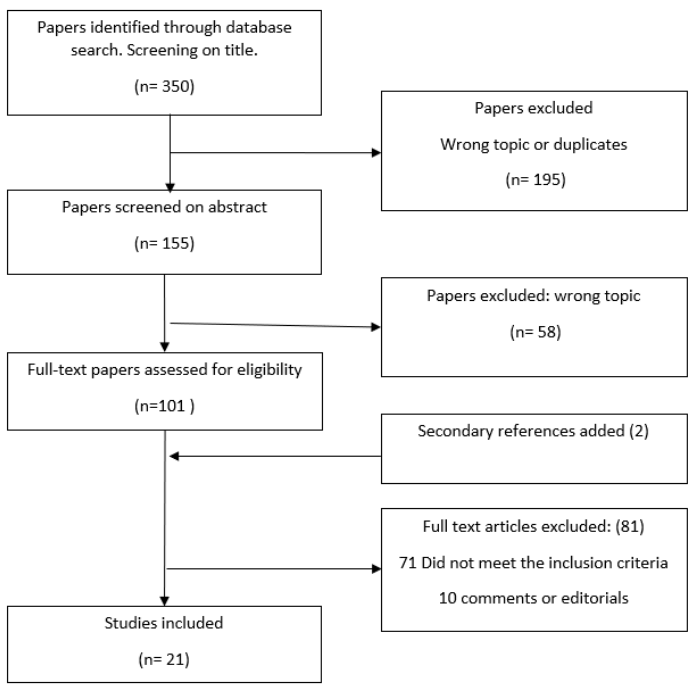
Figure 1. Flowchart of analyzed studies.